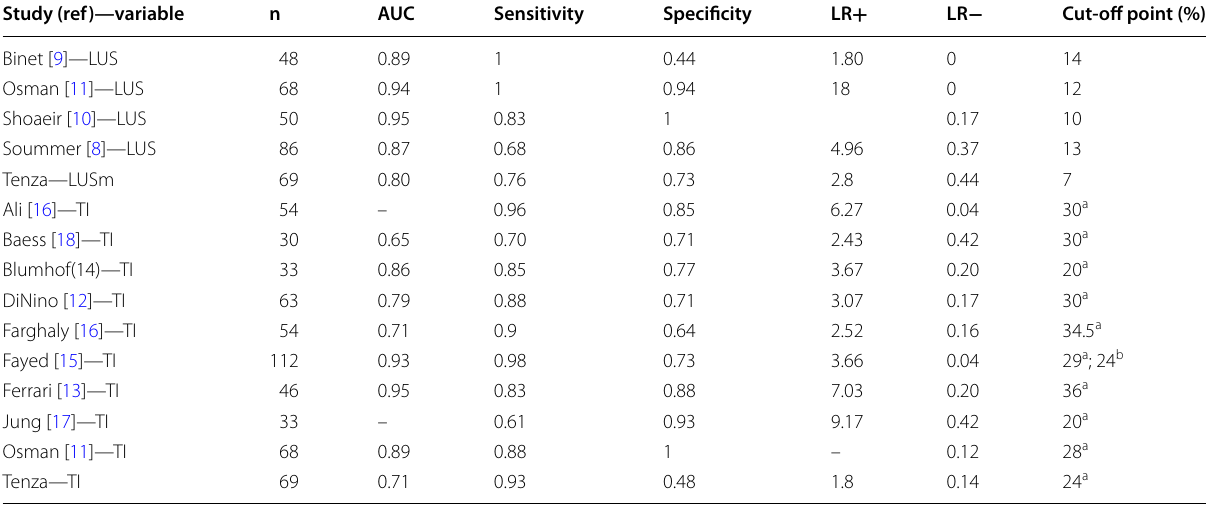
AUC, area under the ROC curve; LR diaphragm thickness index